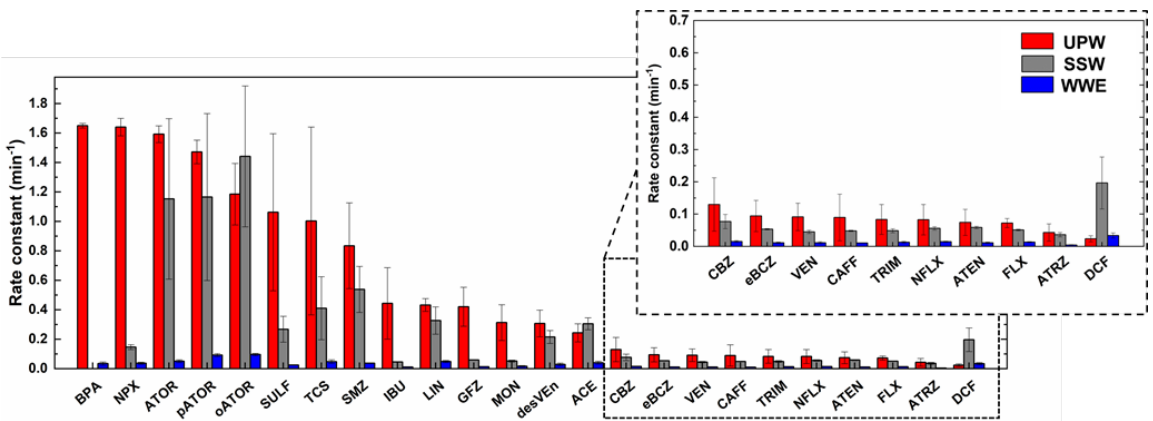
Figure 3. Pseudo first order rate constants for all target compounds during 120 min P25 photocatalysis in ultrapure water (UPW), synthetic surface water (SSW), and wastewater effluent (WWE). Inset magnifies the PPCPs with low k app .